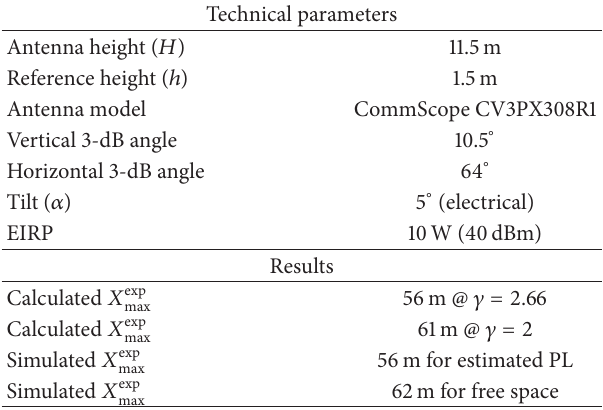
Table 1: BS 1—S˜ao Paulo.